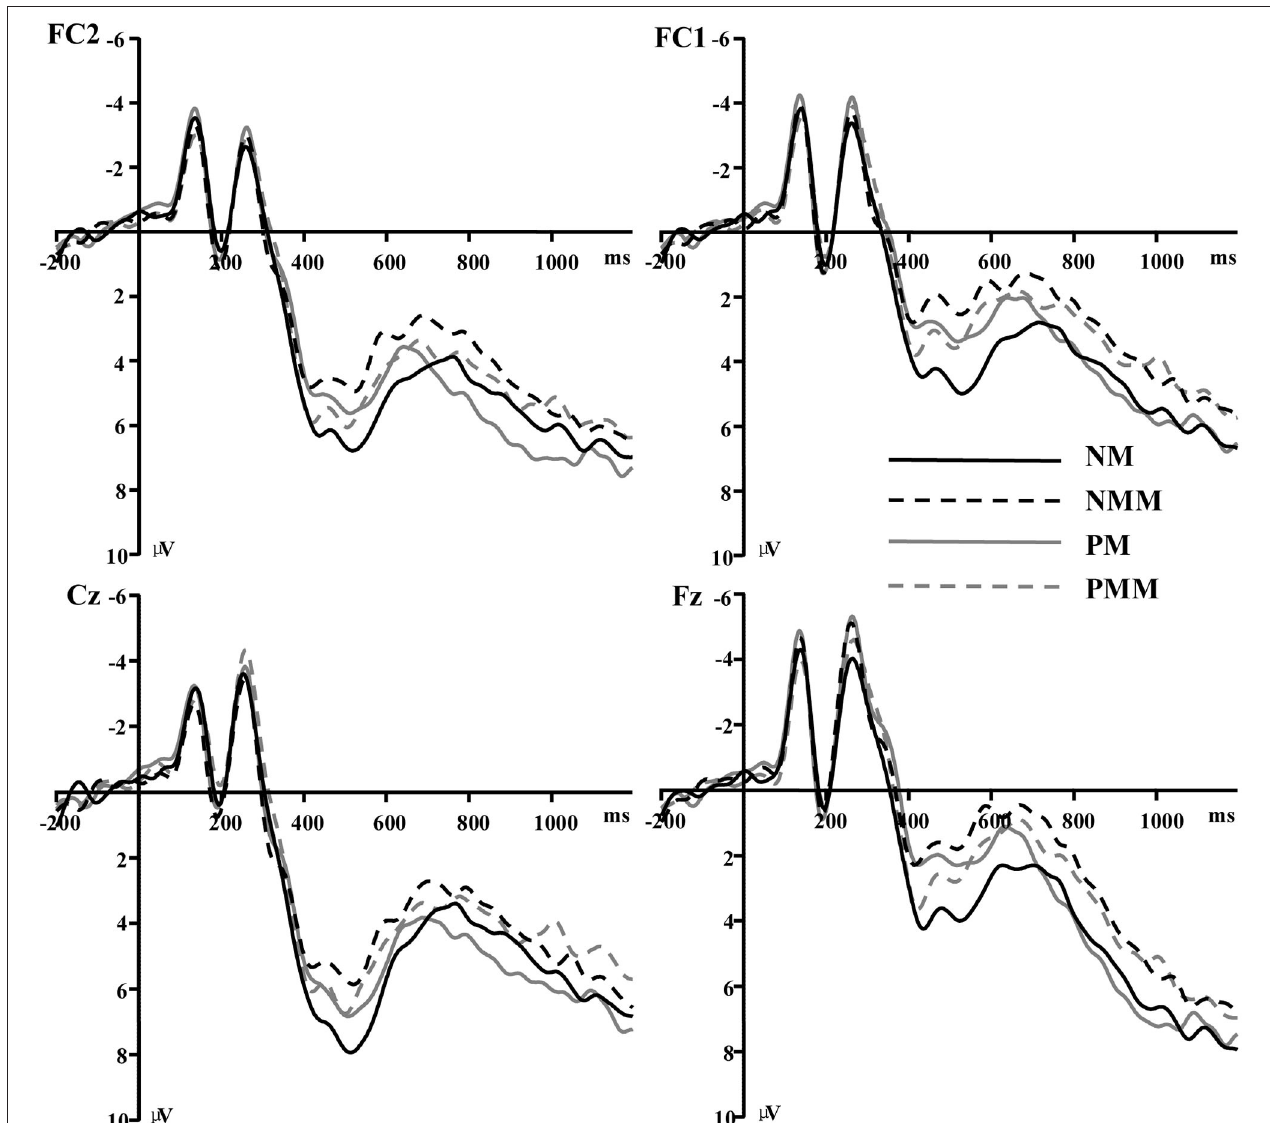
FIGURE 2 | Grand average of event-related potentials recorded in the NMM, NM, PMM, and PM conditions at Fz, Cz, FC1, and